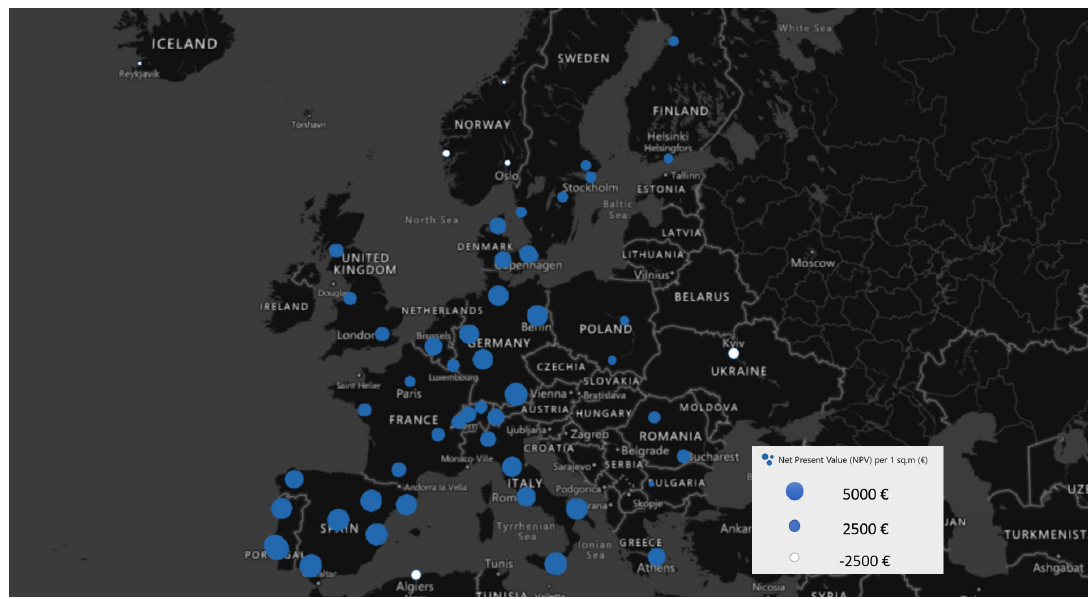
Figure 20. NPV potential per unit collector area in Europe for financing model 1.